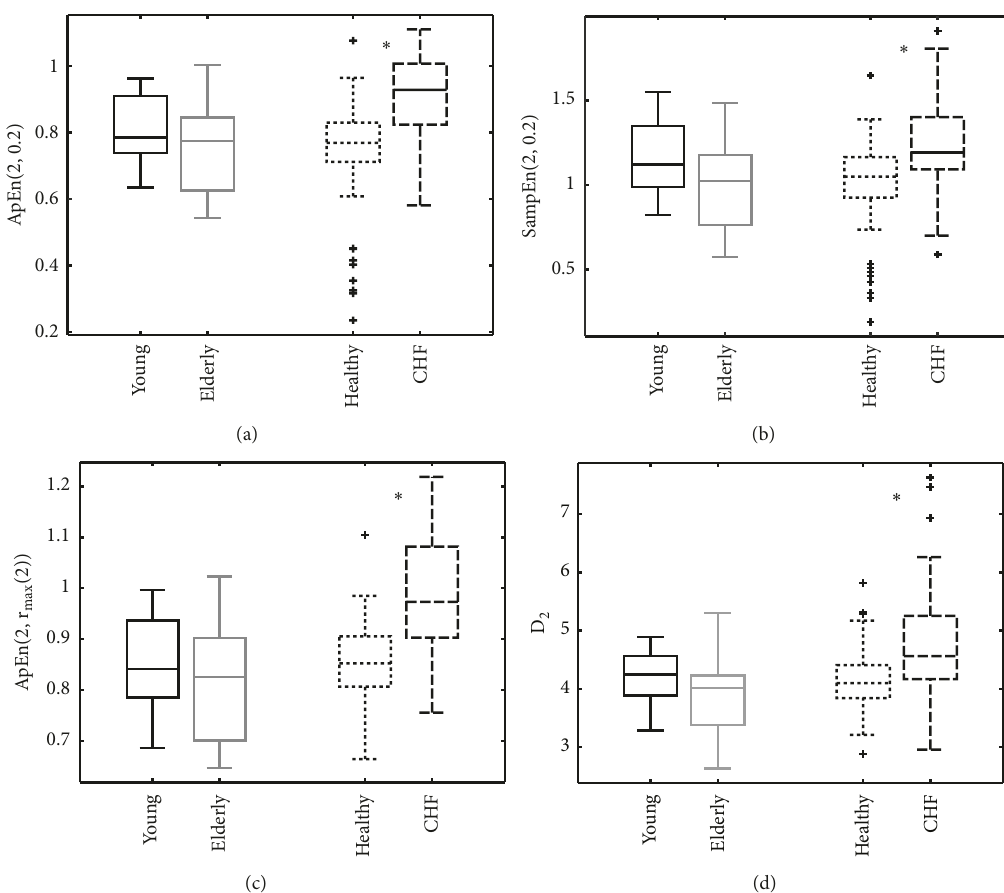
Figure 6: Regularity and complexity indices: (a) ApEn(2,0.2) ; (b) SampEn(2,0.2) ; (c) ApEn(2,r elderly, and healthy subjects versus CHF patients. ∗ indicates statistically significant differences by Mann-Whitney U test ( p -values < 0.05) between groups. Data are shown as median and interquartile range.